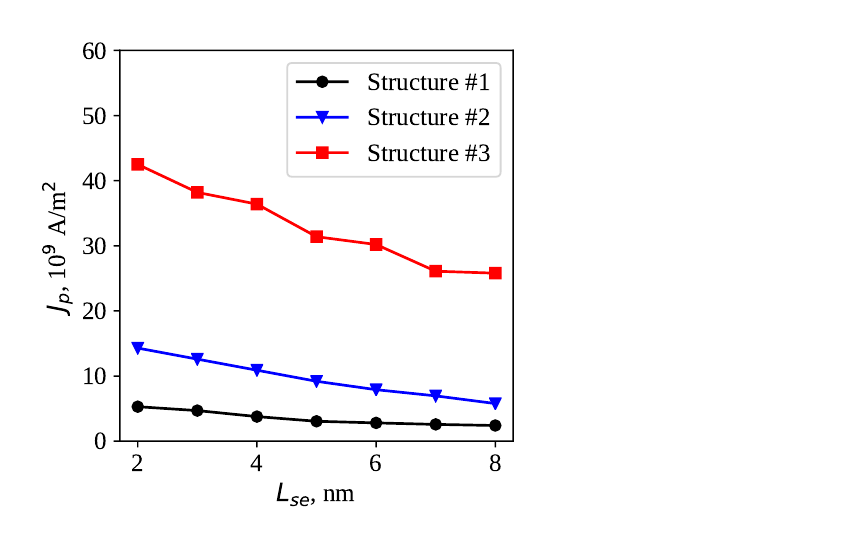
Figure 7. The dependence of the peak current on the thickness of the emitter spacer for the considered resonant tunneling